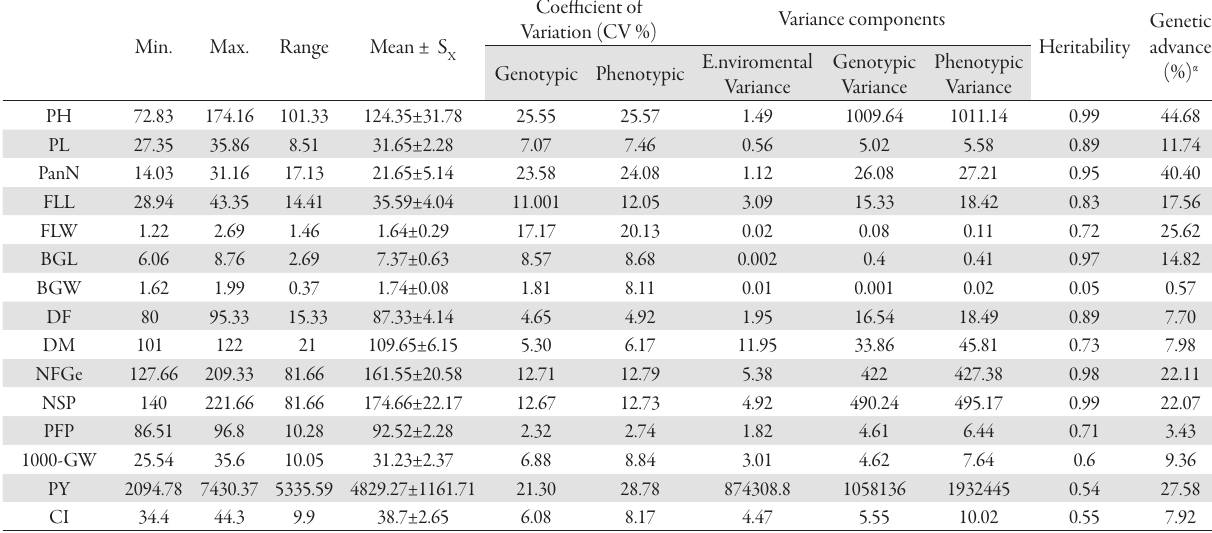
Tab. 3. Estimation of statistical and genetic parameters of studied traits under optimum irrigation regime